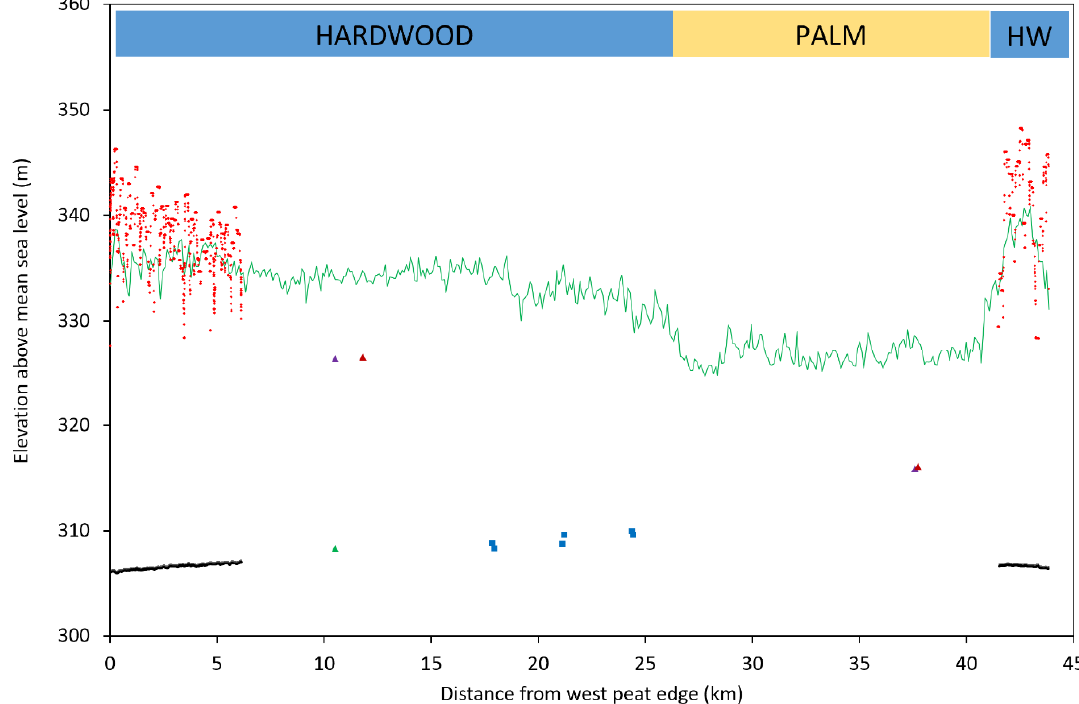
Figure 8. Measured elevations along the Figure 2 Epena–Ekolongouma path from ICESat GLAH06 ( (cid:78) ground, (cid:78) canopy), GLAH14 ( (cid:78) ), ICESat-2 ground returns ( (cid:4) ), UAV LiDAR canopy ( • ), UAV LiDAR ground 100-m moving average ( — ), TanDEM-X ( — ). Forest type at top of figure.